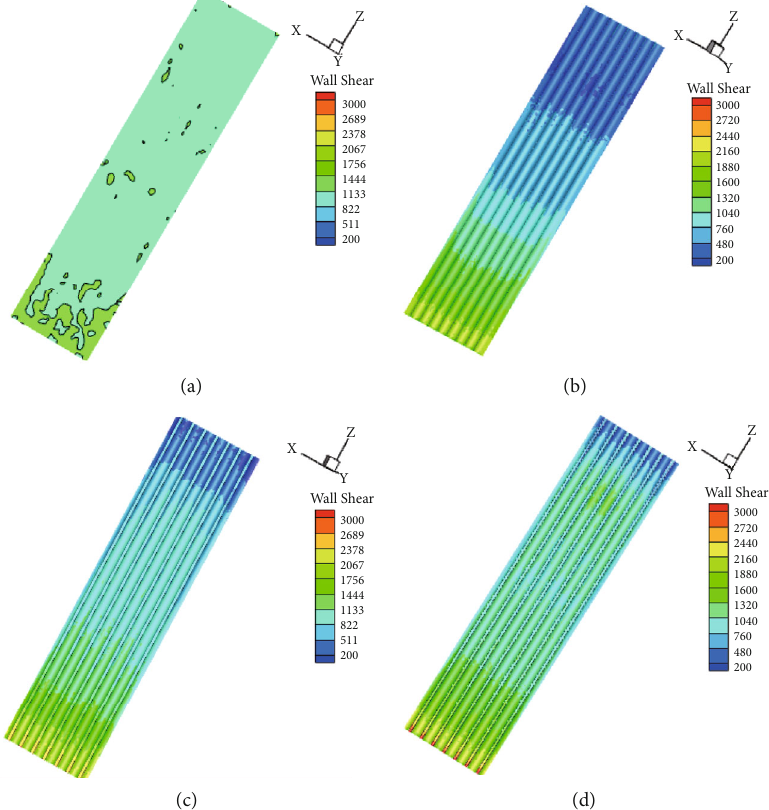
Figure 11: Shear stress comparison. (a) Smooth-groove; (b) Bionic groove I; (c) Bionic groove II; and (d) Bionic groove III.